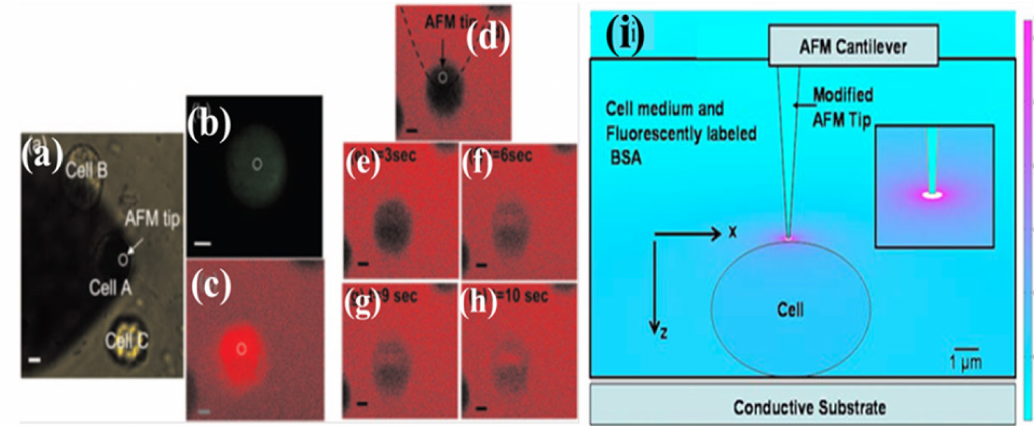
Figure 13. ( a ) bright field image of atomic force microscopy (AFM) tip and the cell in the electroporation medium (cell A is electroporated while cell B and C are about 20 µm away from cell A); ( b ) Fluorescence image of rat fibroblast cell after electroporation; ( c ) Confocal fluorescence image of an electroporated cell; ( d ) – ( h ) Sequence of real time confocal fluorescence images of rat fibroblast cell after electroporation; ( i ) Calculated spatial distribution of electric field in the vicinity of the cell being